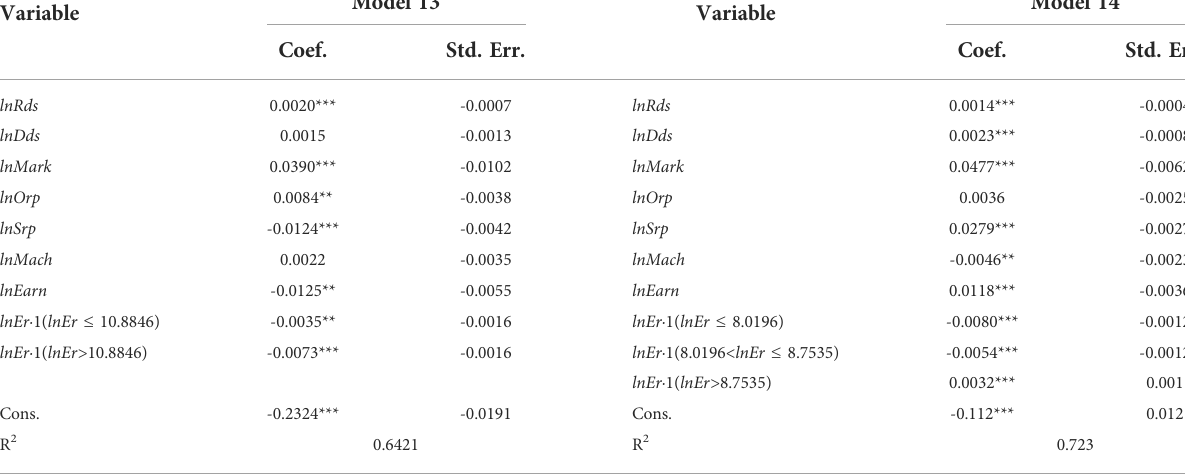
TABLE 9 Panel threshold model estimation results.